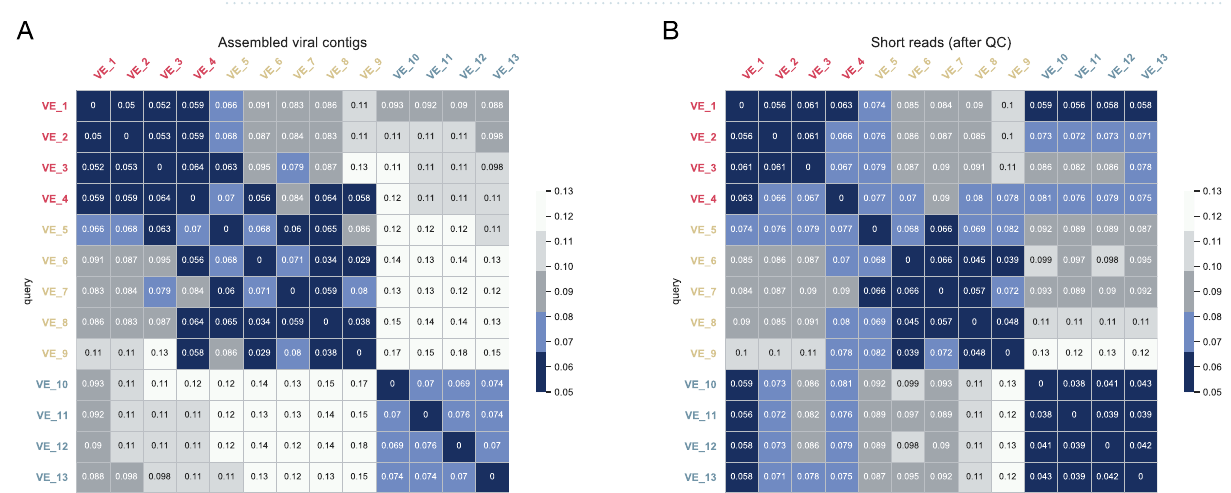
Figure 8. ( A ) Jaccard distance analysis of assembled viral contigs of 13 pooled farm dust samples. ( B ) Jaccard distance analysis of quality-controlled short reads of 13 pooled farm dust samples. The color intensity of the heatmaps is determined by MASH distance. Corresponding MASH distances are also shown in the heatmap. Sample labels are color-coded by farm ID and farm ID was added as prefix for